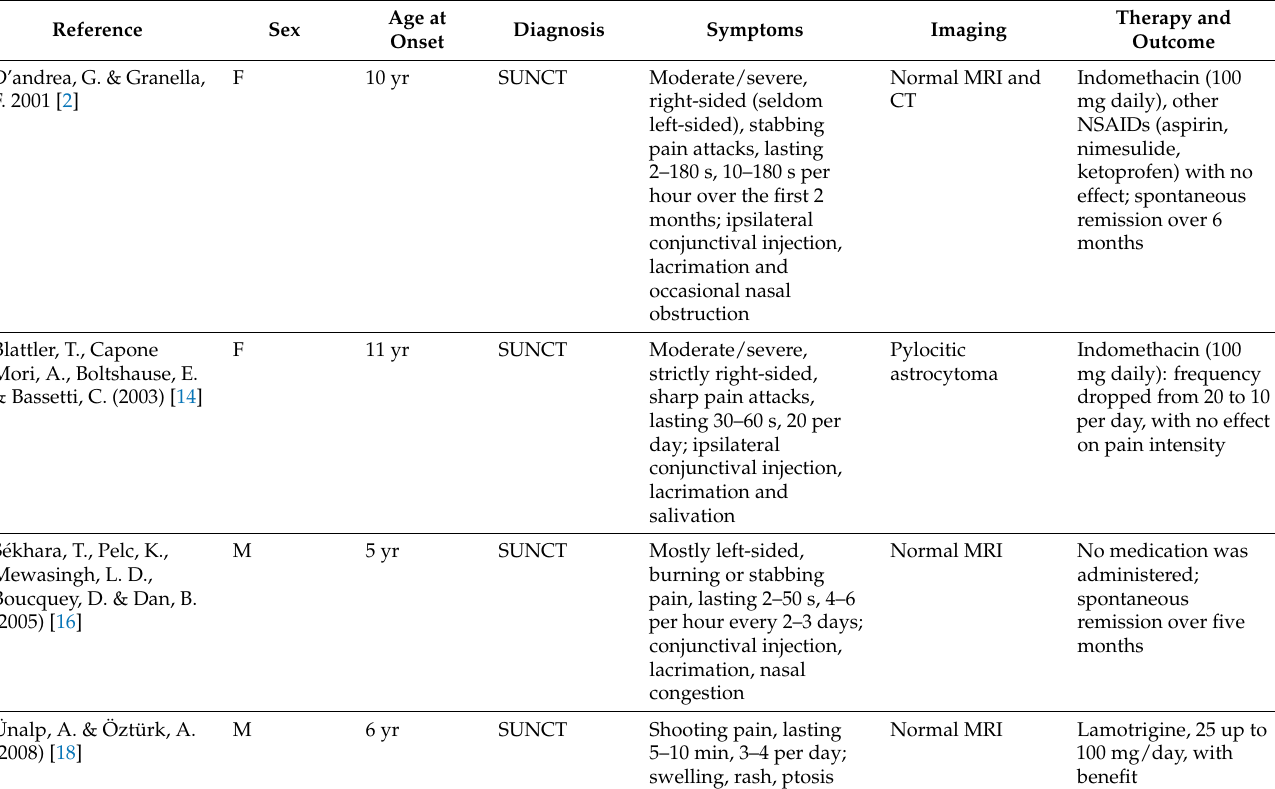
Table 1. Reports of pediatric SUNCT